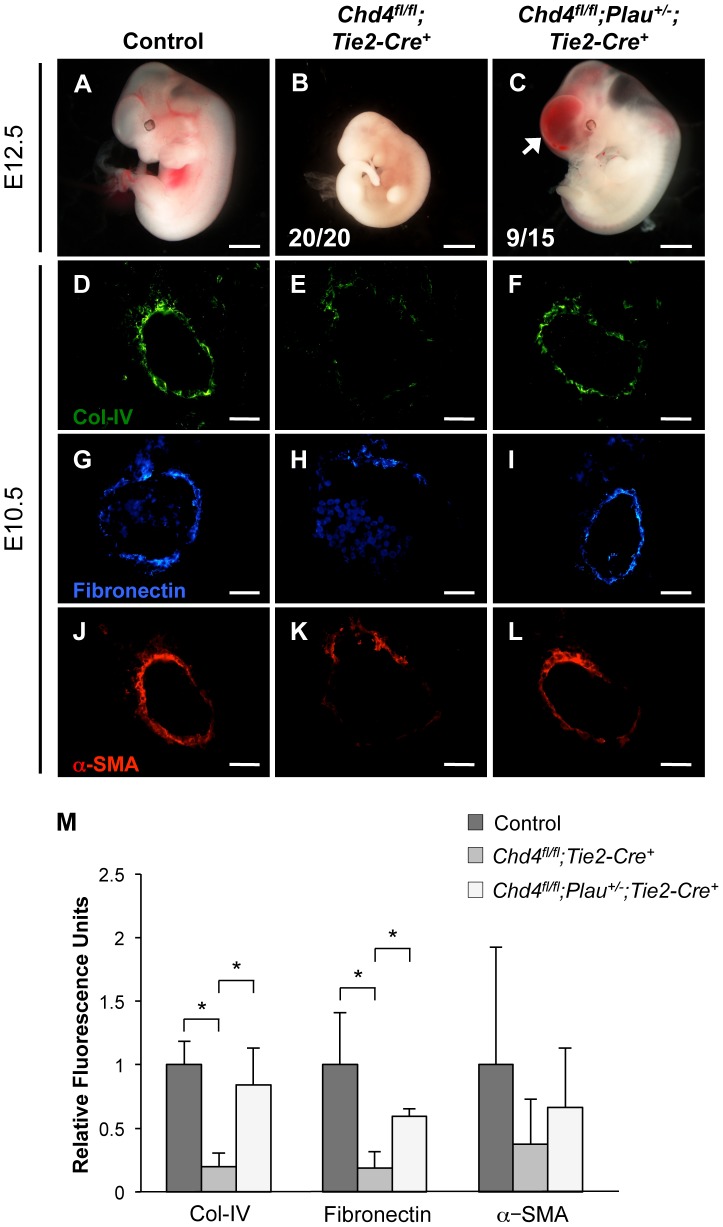
Genetic reduction of urokinase restores ECM components and partially rescues vascular rupture in Chd4fl/fl;Tie2-Cre+ embryos.(A–C) Representative images of littermate control (A), Chd4fl/fl;Tie2-Cre+ (B), and Chd4fl/fl;Plau+/−;Tie2-Cre+ (C) embryos at E12.5. All Chd4fl/fl;Tie2-Cre+ embryos examined (20/20) were pale and necrotic (B). 60% of Chd4fl/fl;Plau+/−;Tie2-Cre+ embryos (9 out of 15) were comparable in size to littermate control embryos, although they displayed blood in the brain (arrow) and/or spinal cord (C). (D–L) Histological sections of dorsal aortae from E10.5 control, Chd4fl/fl;Tie2-Cre+, and Chd4fl/fl;Plau+/−;Tie2-Cre+ embryos were stained with antibodies against type IV collagen (Col-IV; D–F), fibronectin (G–I), or α-SMA (J–L). Scale bars: 1 mm (A–C); 50 µm (D–L). (M) Quantification of immunostained ECM components, such as those shown in panels D–L. Relative fluorescent intensity was measured and normalized to fluorescence in the control sections. Error bars represent SD of results from three independent experiments using three different sets of littermate embryos. Significant differences were calculated using a two-tailed Student's t test (*, p<0.05).